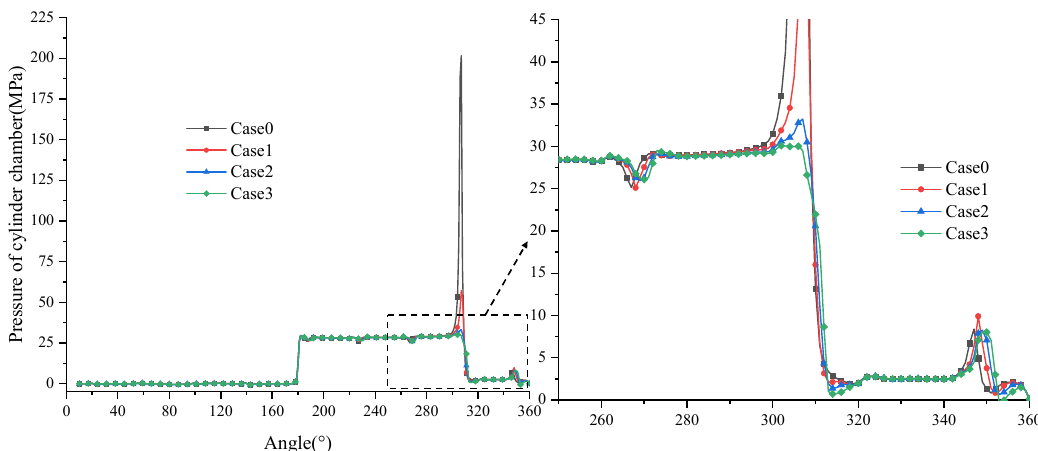
Figure 7. Pressure pulsation in cylinder chamber of four cases.